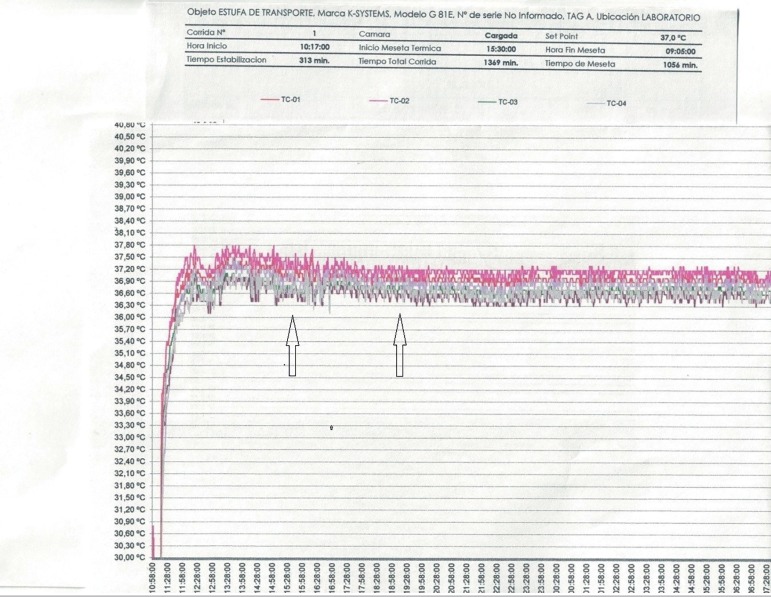
24-hour temperature control test of portable incubator. The incubator
was connected to a 220-volt power outlet except for a period of four
hours (area between arrows), during which the incubator was running
on batteries